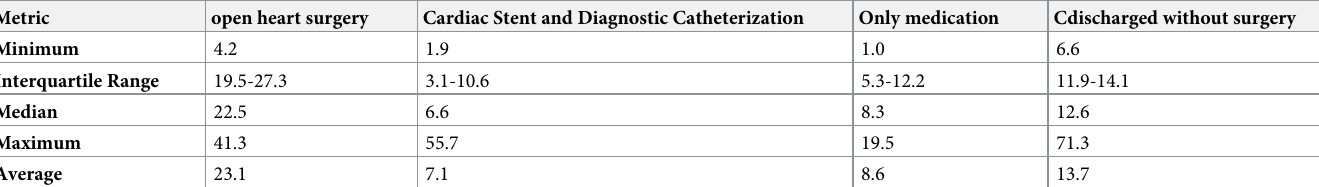
Table 9. Length of the patient journey (in days) into hospital according to the patient diagnostics.